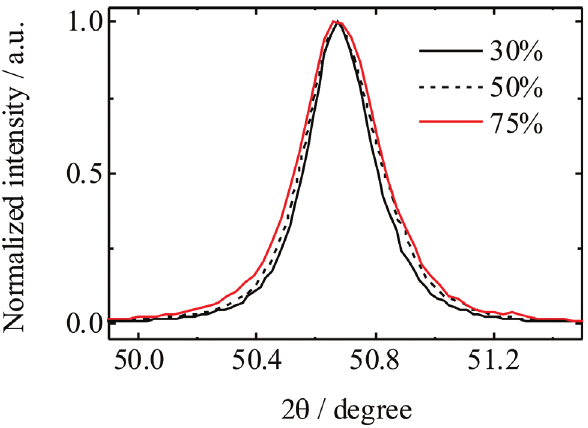
Figure 7: 200 reflections of the copper component of the cold-rolled sheets at reductions of 30, 50, and